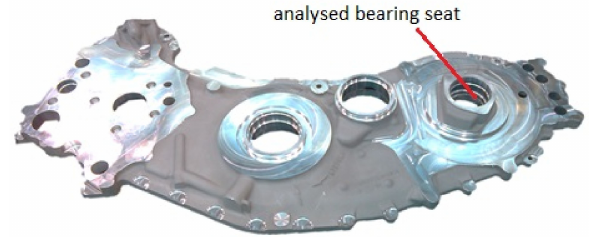
Figure 5. Tested workpiece after the machining operation—top view (machined surfaces visible as